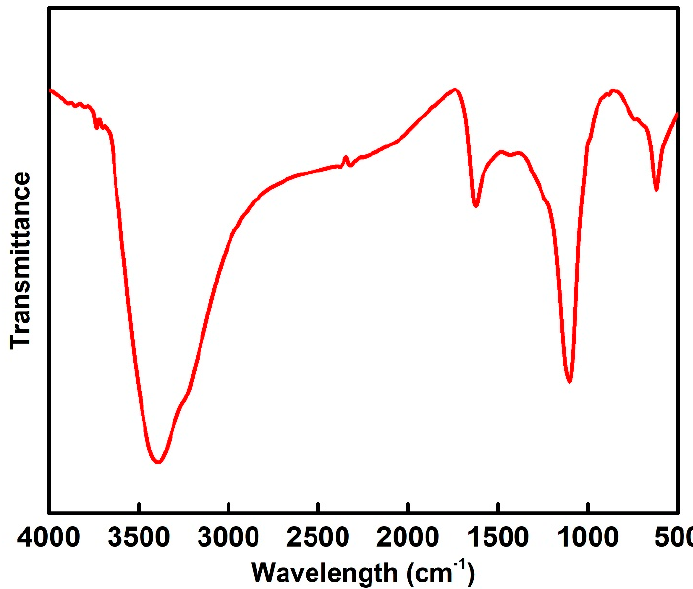
Figure 4. FTIR spectra of the synthetic S-C sample.